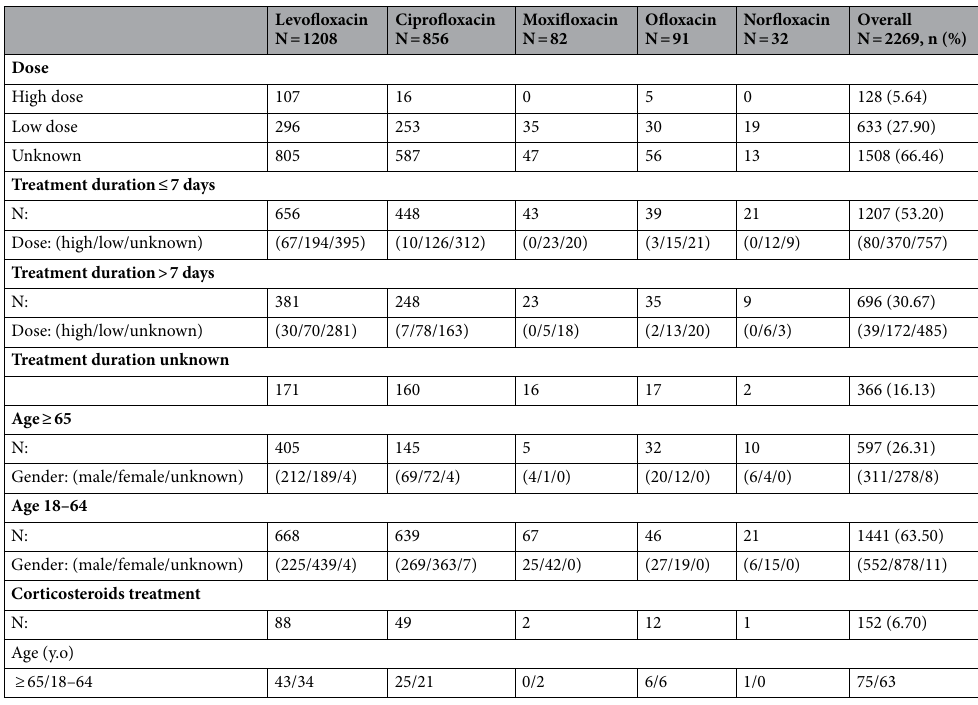
Table 3. Tendon related reports with associated risk factors. N number of FQs numbered once per report; n number of FQs numbered once per report, in a given category; NA not applicable; y.o years